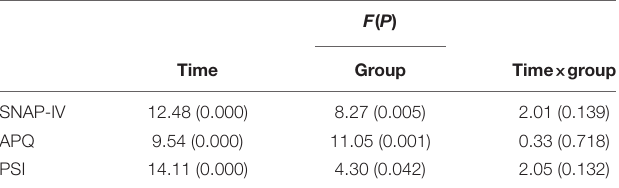
TABLE 3 | Results of mixed effect models of the outcome measures between the intervention group and the control group.